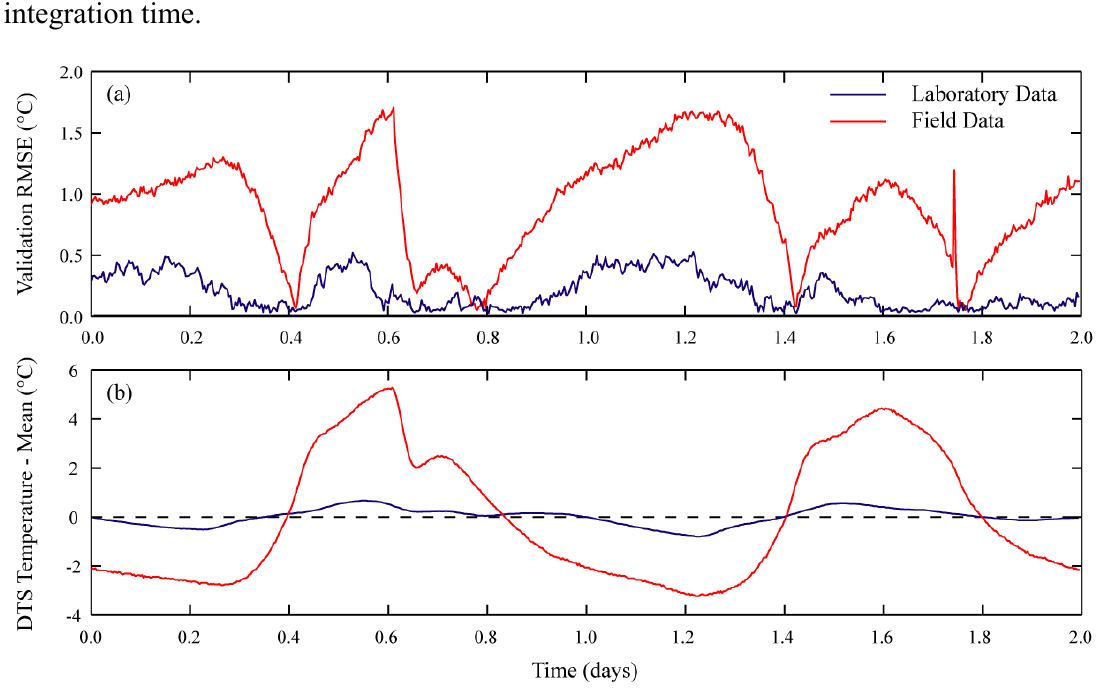
Figure 5. The influence of instrument temperatures on static calibrations. (a) Validation bath RMSE of the static calibrations for the two case studies presented here. (b) Difference between the mean instrument temperature and the instrument temperature during the integration